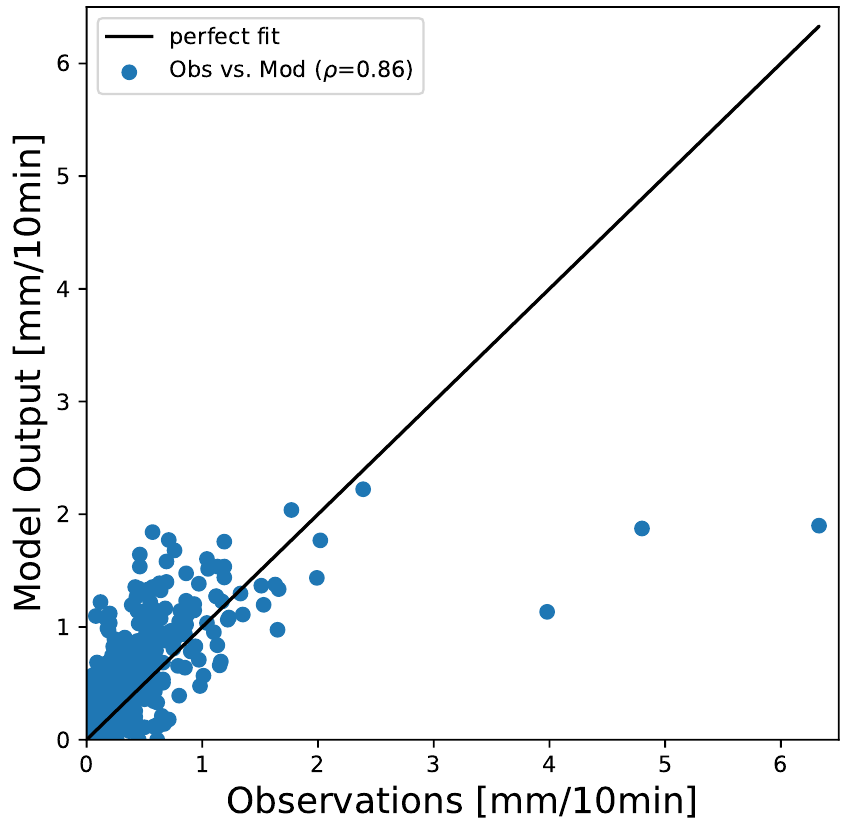
Figure 7. Scatter plot for observed (Obs) and modelled (Mod) precipitation at location Hohenpeis- senberg in 10-min time resolution. Validation period (20% of the available data